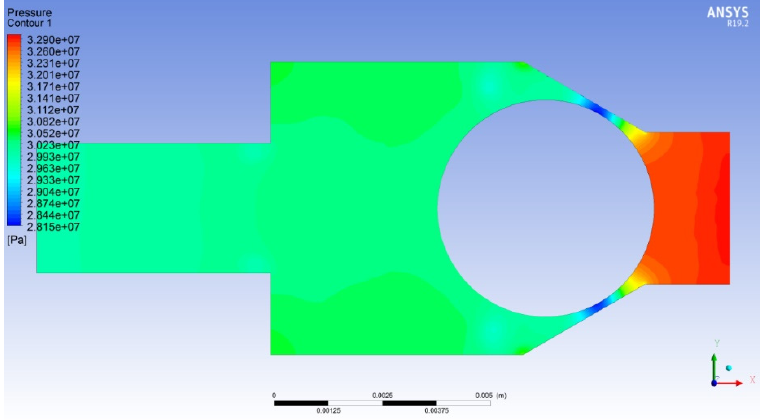
Figure 7. Pressure CFD: Conical seat valve x = 0.201 [mm], pdn = 300 [bar] and pup = 330 [bar].